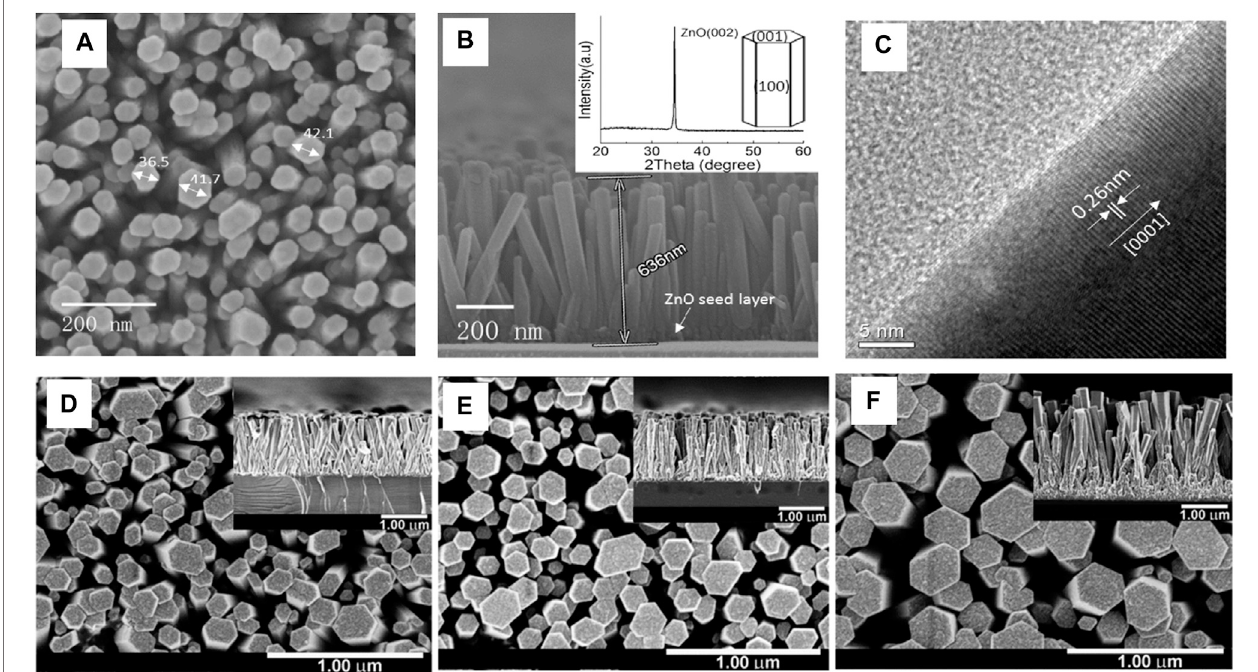
FIGURE 6 | (A) A typical top-view SEM image of ZnO nanorod arrays; (B) A typical cross-sectional SEM image of ZnO nanorod arrays (inset shows a typical X-ray diffraction pattern ofZnOnanorod arrays and theoretical growth habit ofZnOcrystal) (C) Atypical plane-viewHRTEM image ofasingle ZnO nanorod detached from the sample(Quetal.,2017);Top-viewandcross-sectional(inset)FE-SEMimagesofZnOnanorodsgrownon13ZnOseedlayersdepositedfor (D) 10, (E) 20and (F) 30 min (Yu et al.,